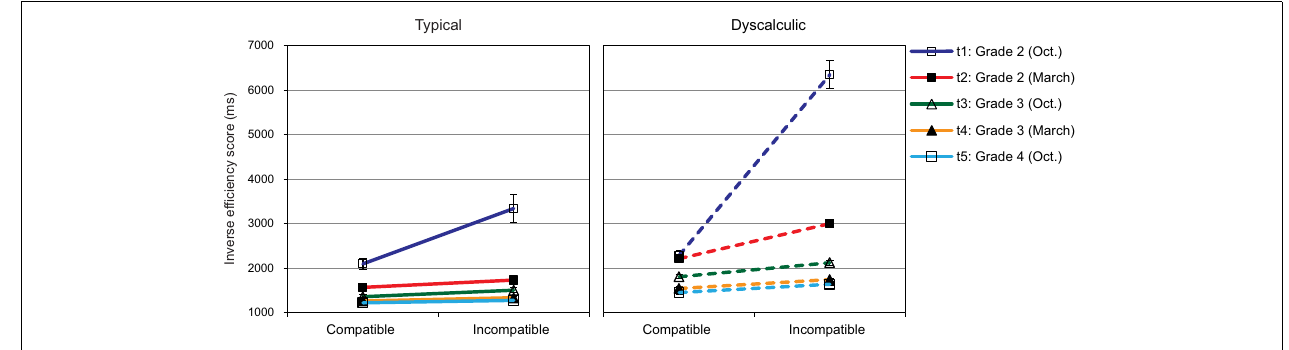
FIGURE 7 | Comparison of two digit numbers: Mean IE-scores (SEs as error bars) for compatible and incompatible items across five assessment points.